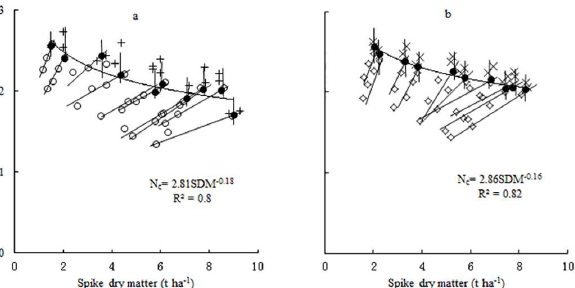
Fig 3. Critical N data points used to develop spike N c curves. a: 2009–2011NM13, b: 2009–2011 YM16. The symbols ( (cid:5) ) and ( (cid:14) ) represent the data points obtained from the N-limitingtreatments for YM16 and NM13, and ( × ) and (+) represent the data points obtainedfrom the non-N-limiting treatments for YM16 and NM13. The symbols ( ● ) represent the calculatedN c points for each samplingdate. The solid line represents the spike N c curve that describesthe relationshipbetween spike N c concentration and SDM of winter wheat.